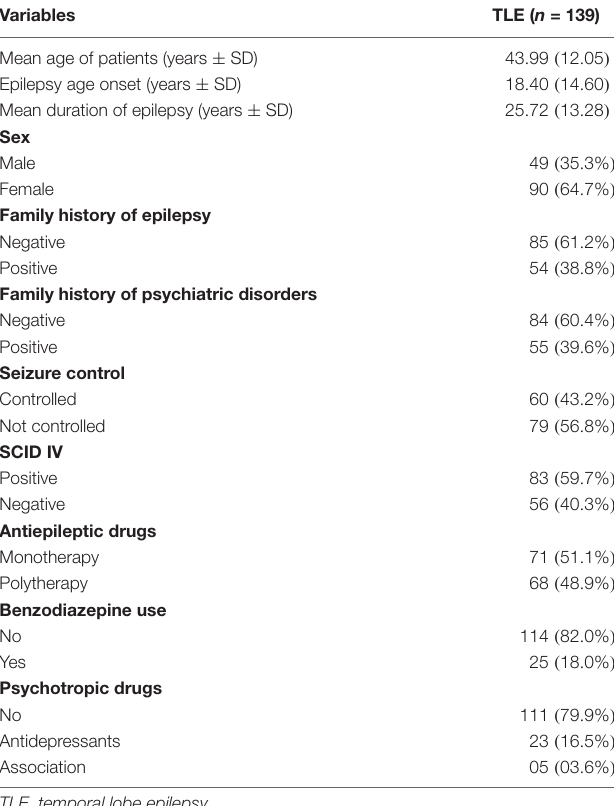
TABLE 1 | Clinical variables of TLE patients.